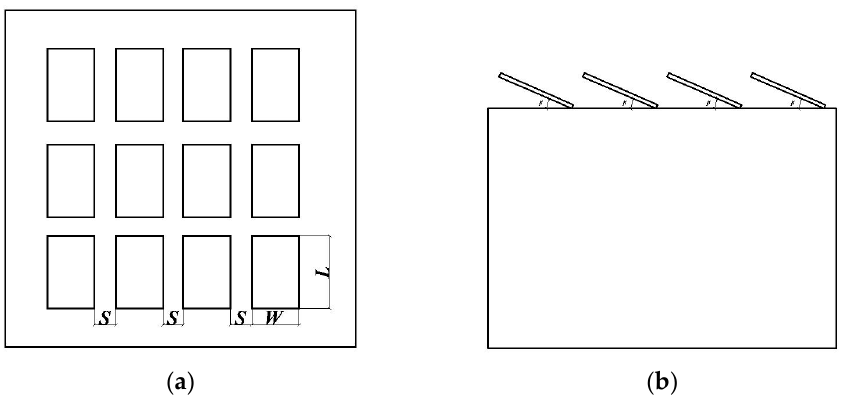
Figure 6. De fi nition of PV panel arrays mounted on fl at roofs: ( a ) Horizontal view; ( b ) Vertical view.